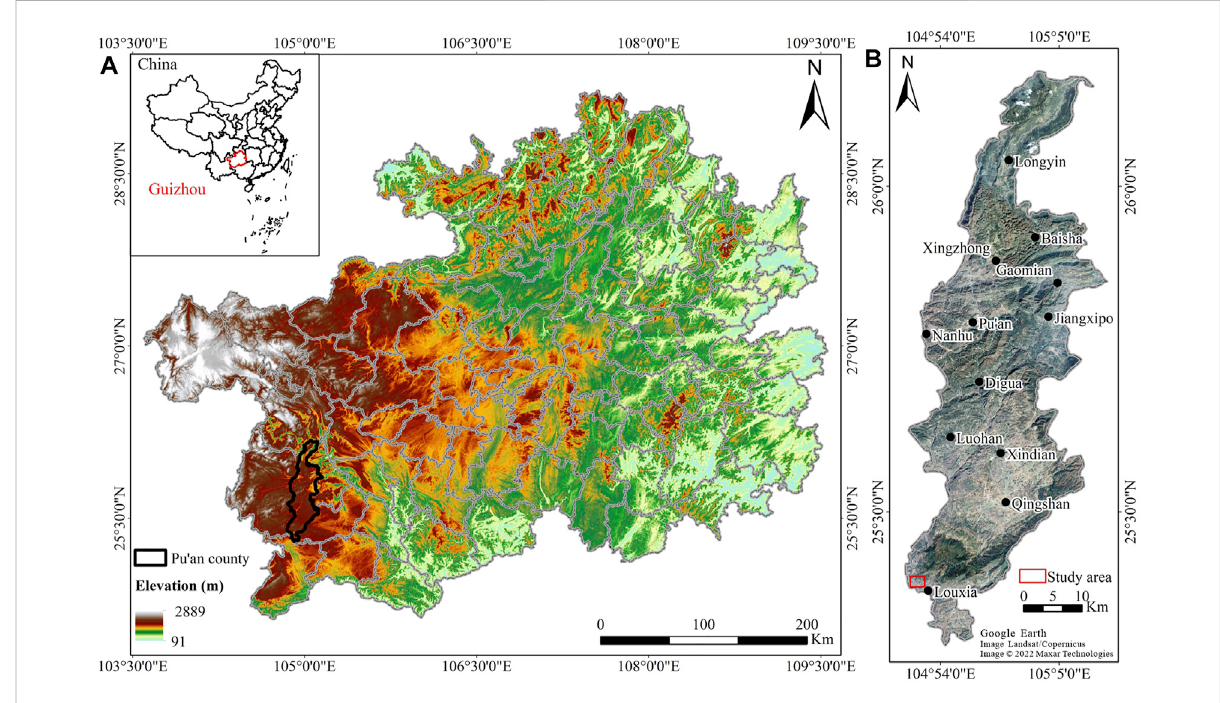
FIGURE 1 (A) Location of Pu ’ an county (image source: SRTM data) and (B) location of the study